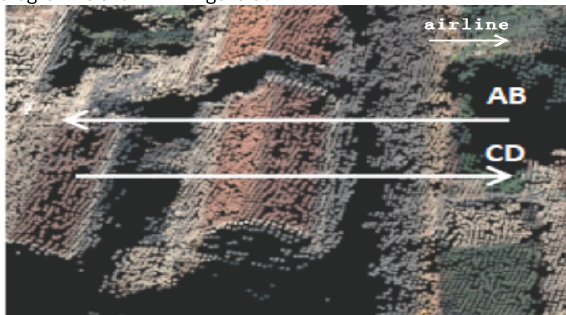
Figure 8. Flight airline design